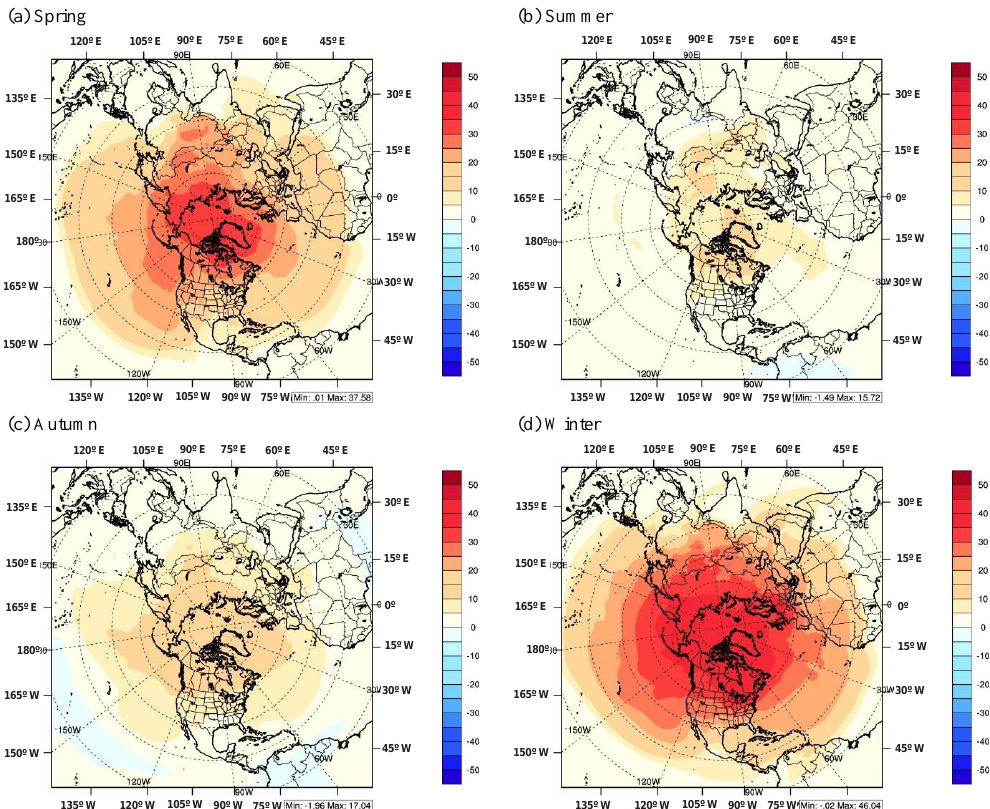
Figure 9. Relative changes in surface O 3 due to dynamic O 3 / PV function (unit: %, *changes = (Sim-new minus Sim-off)/Sim-new ).